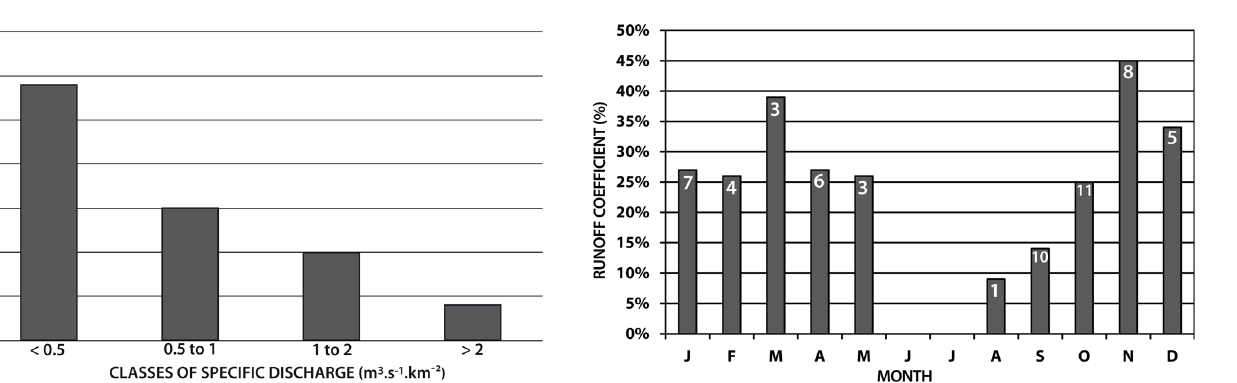
Fig. 5. Average runoff coefficient per month (number of events used to calculate the average is indicated inside